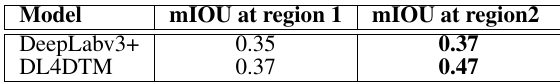
Table 2. mIOU scores for both models on two test regions